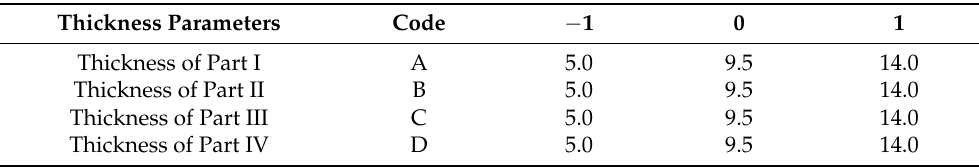
Table 3. Thickness parameters and experimental design levels.